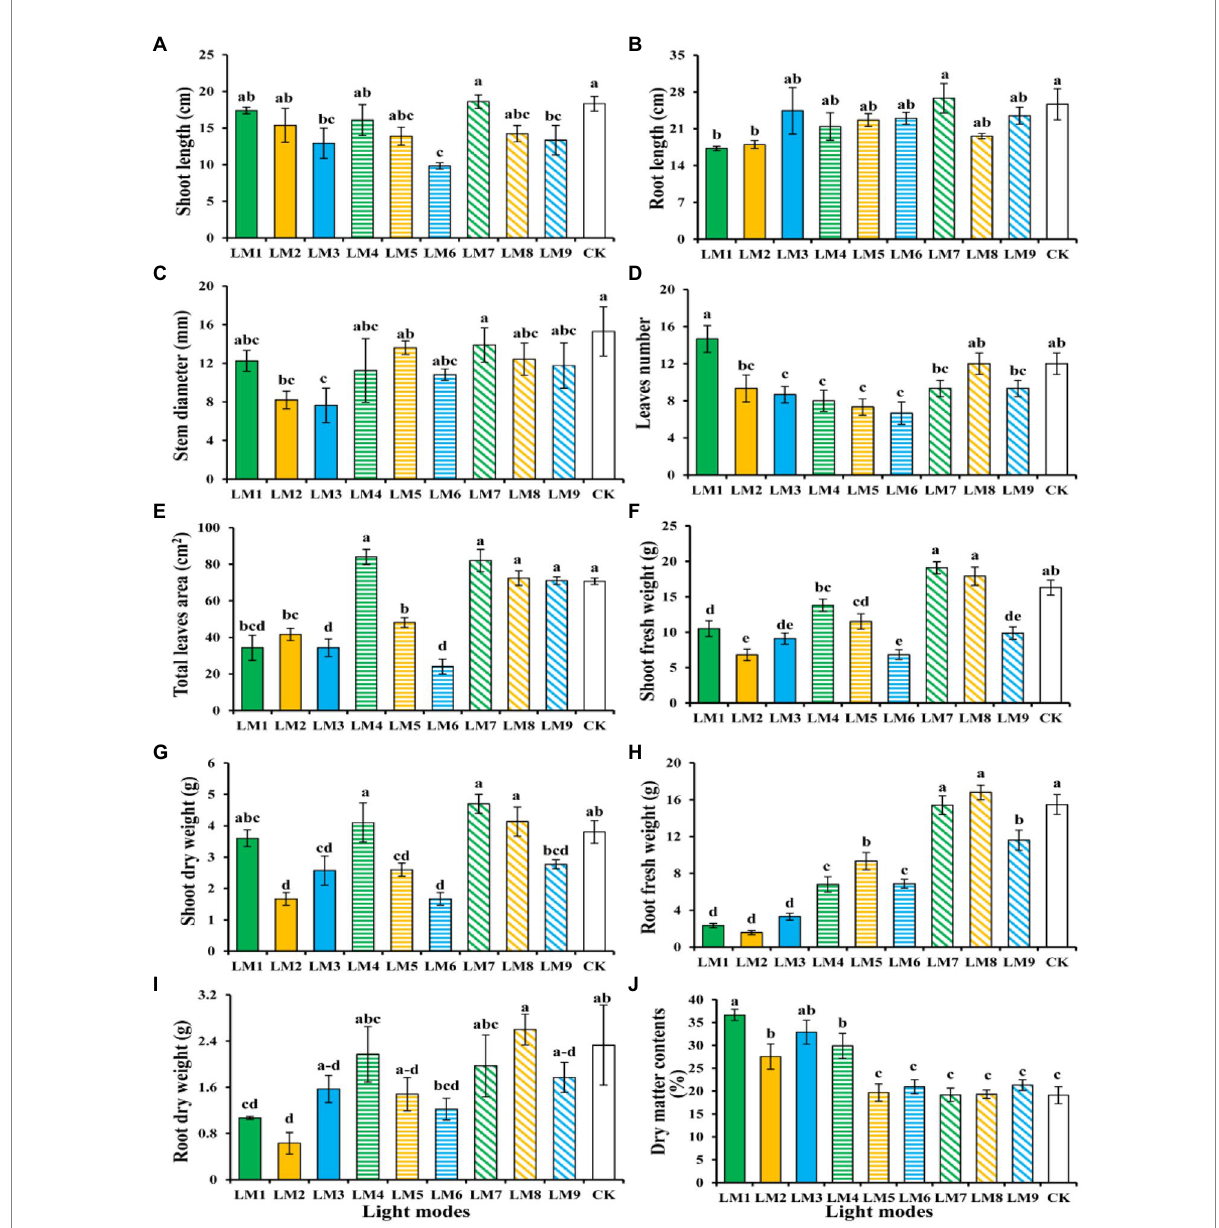
FIGURE 3 The influence of modes of LED light on plant morphology and growth characteristics of strawberry plants; Shoot length (A) , root length (B) , stem diameter (C) , number of leaves (D) , total leaf area (E) , shoot fresh weight (F) , shoot dry weight (G) , root fresh weight (H) , root dry weight (I) , and dry matter contents % (J) . Each column represents the means of three technical replicates ( n = 5); the same letter within the same series is not significantly different according to Duncan’s multiple range test ( p ≤